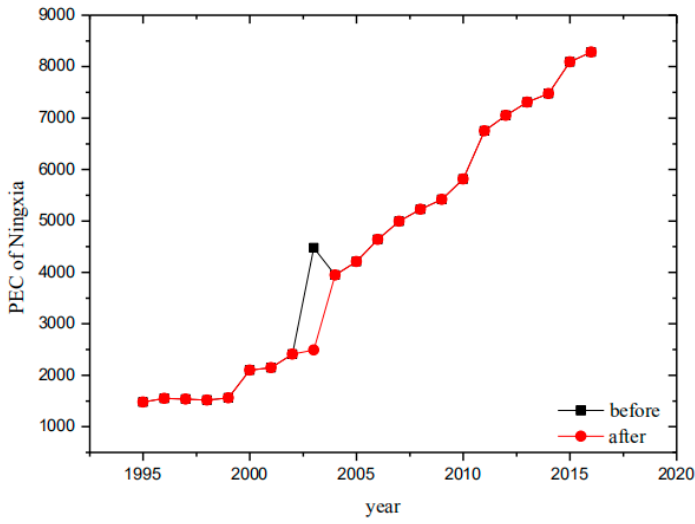
Figure 3. The per capita energy consumption data before and after correction of Ningxia (kce / person). The data fluctuations become stable and no sharp changes occur.